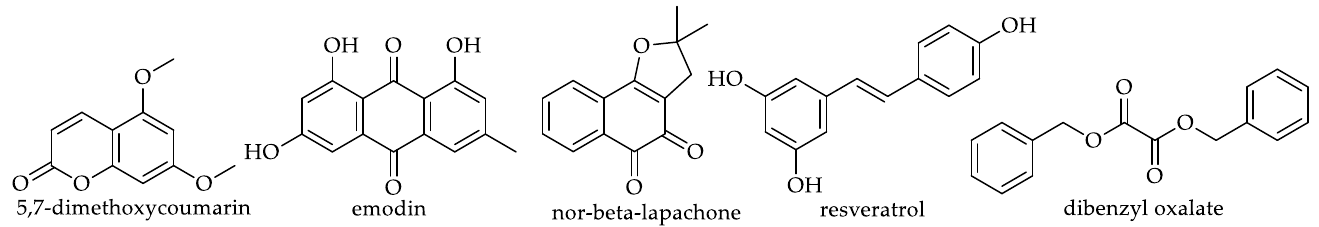
Figure 21. Structure of 5,7-dimethoxycoumarin ( 157 , Table 15), emodin ( 158 , Table 15), nor- β - lapachone ( 159 , Table 15), resveratrol, a stilbene ( 160, Table 15), and dibenzyl oxalate, an oxalate ester ( 161, Table 15) reported in honeys. Table 15. Hydroxycoumarin, anthraquinone, naphthoquinone, stilbenes and benzyl oxalate ester reported in monofloral